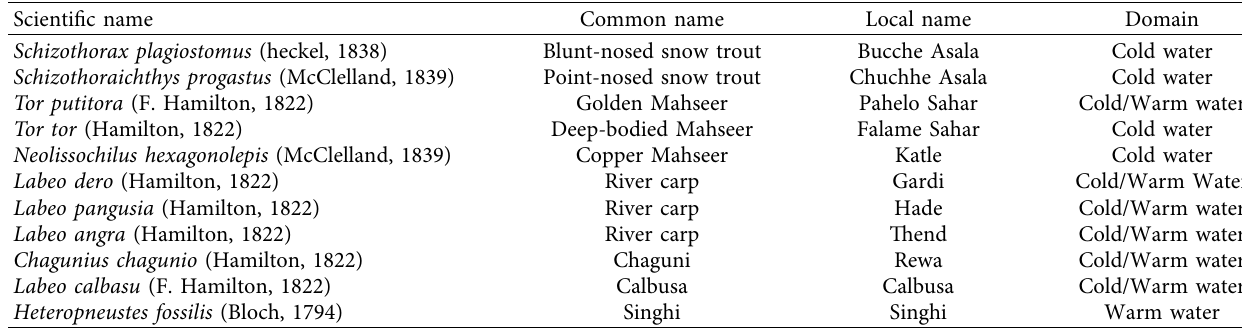
Table 5: List of commercially important indigenous fin fishes (artificially bred) in Nepal.